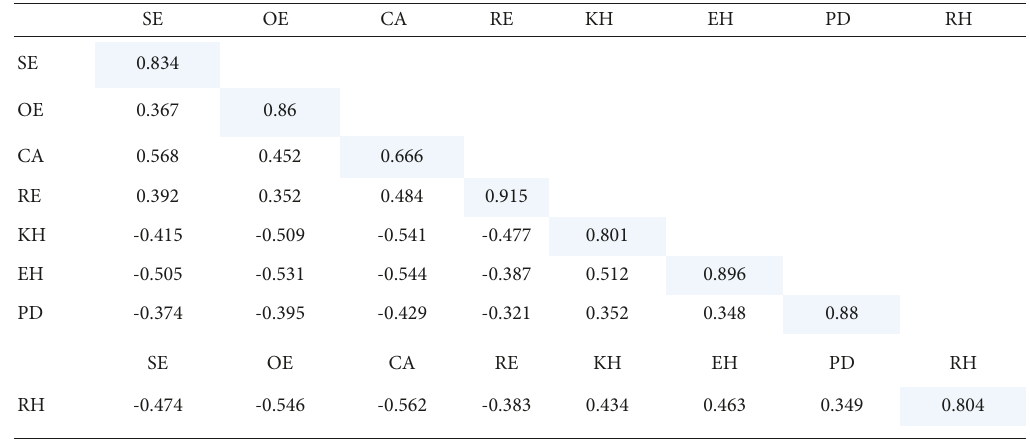
Table 7: Pearson correlation and AVE root value.